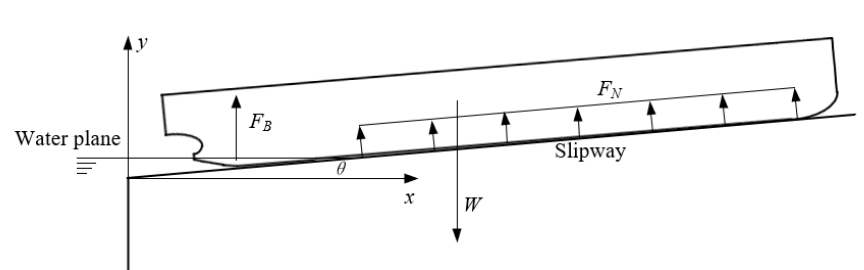
4 of 19 Figure 2. Overview of methodology for the ship’s longitudinal launching.